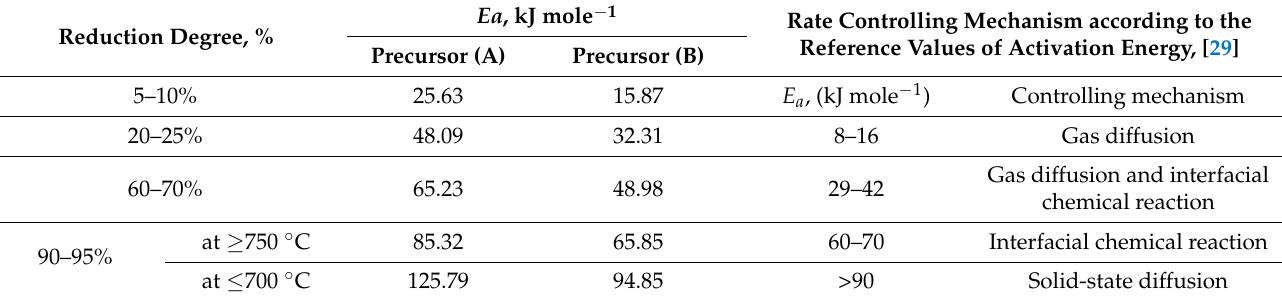
Figure 8. Arrhenius plots for the reduction of precursors with H 2 at 600–850 ◦ C: ( a ) precursor A; and ( b ) precursor B. Table 3. E a values computed for the reduction of precursors at 600–850 ◦ C and the proposed corresponding reaction